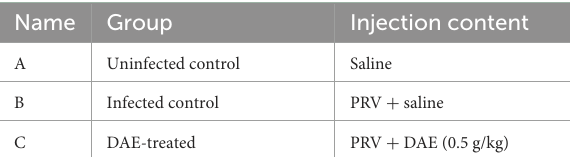
TABLE 1 Groups of animal